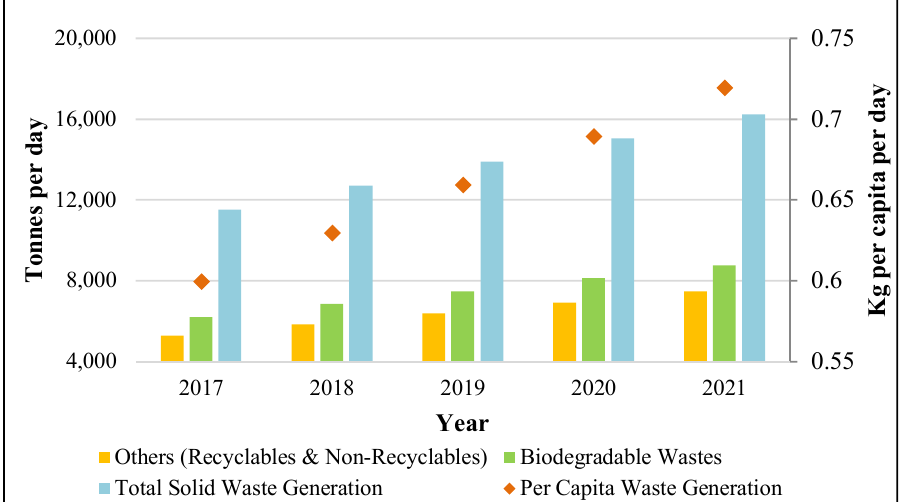
Figure 3. The contribution of biodegradable wastes in the total solid waste generation in Myanmar. Note: The contribution of biodegradable wastes in the total solid waste generation was estimated based on the World Bank 2012 Report, regarding the waste composition and the total solid waste generation of Myanmar. The data were considered only until 2021, since waste composition may change with the development of the economy and living standards of people in Myanmar.